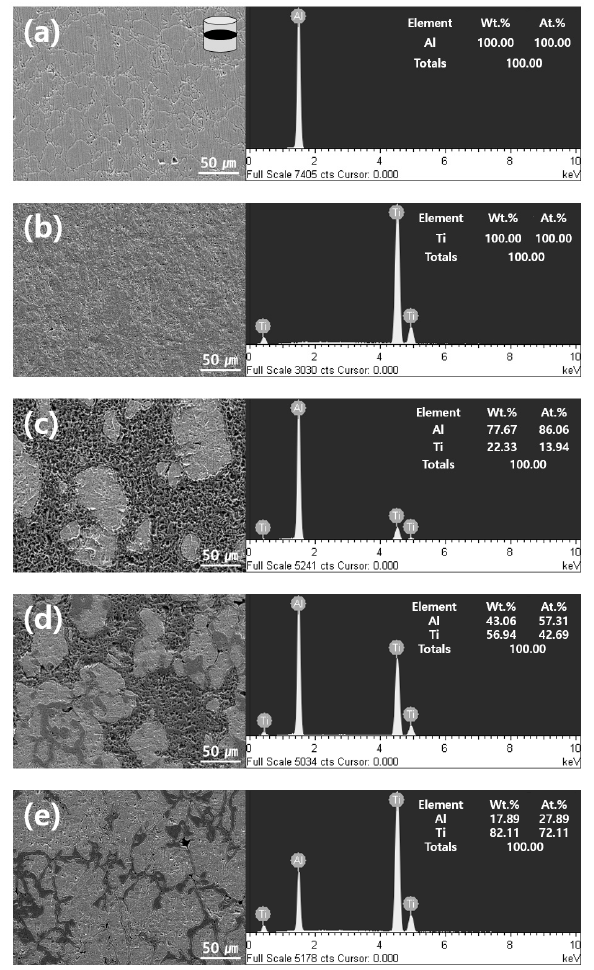
Figure 8. SEM images and EDS spectra of ( a ) pure Al; ( b ) pure Ti; ( c ) Al-20 vol.% Ti; ( d ) Al-50 vol.% Ti, and ( e ) Al-80 vol.% The Ti composites are shown illustrating transverse cross-sections of the samples.